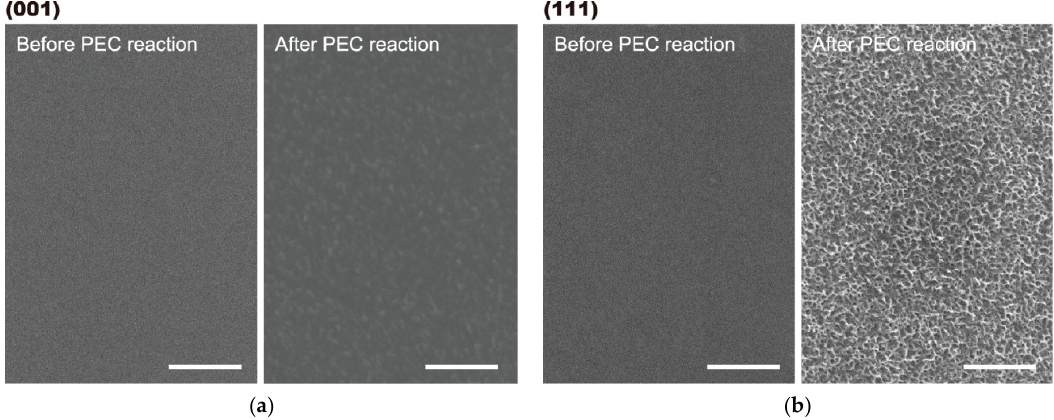
Figure 6. The surface morphology for the ( a ) (001)- and ( b ) (111)-planes of TiO 2 :Nb substrates before and after the PEC reaction at 1.5 V RHE for 1 h in 1 M KOH electrolyte. The white scale bars represent 500 nm. Catalysts 2019 , 9 , x FOR PEER REVIEW